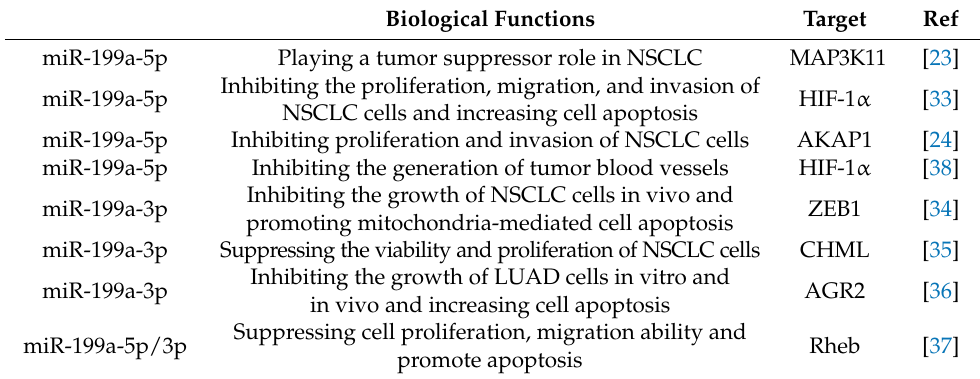
Table 1. miR-199a regulates cell functions and tumor angiogenesis in lung